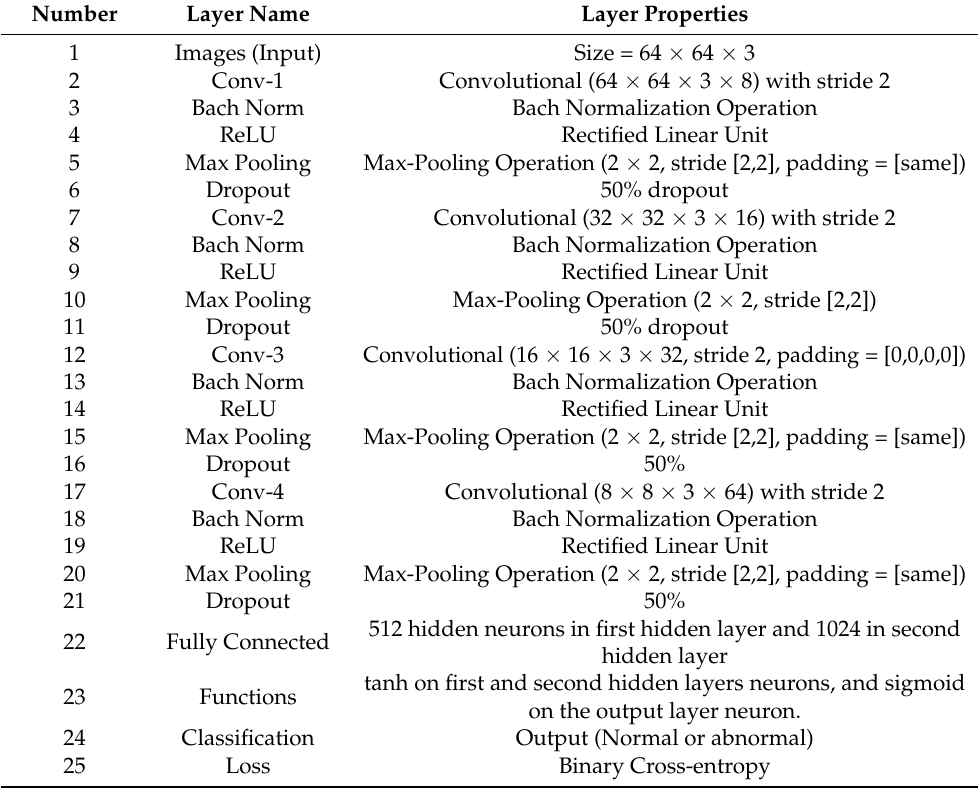
Table 3. All network layers are listed with their